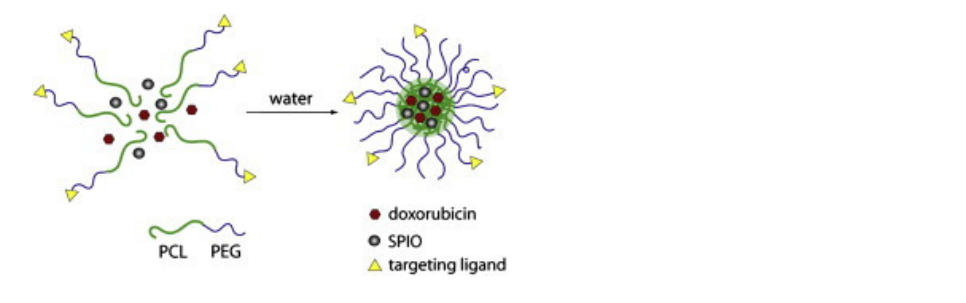
Figure 7. Schematic illustration of metal ions induced complex micelles for drug encapsulation. Reprinted with permission from ref. [183]. Copyright © 2018 Elsevier B.V.